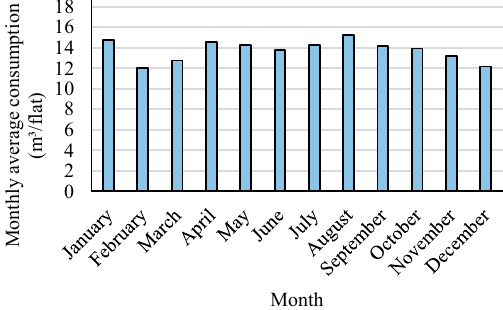
Figure 4. Average, maximum and minimum monthly consumption of water per flat (data from 2011 to 2018, excluding consumption of water from toilet flushes).